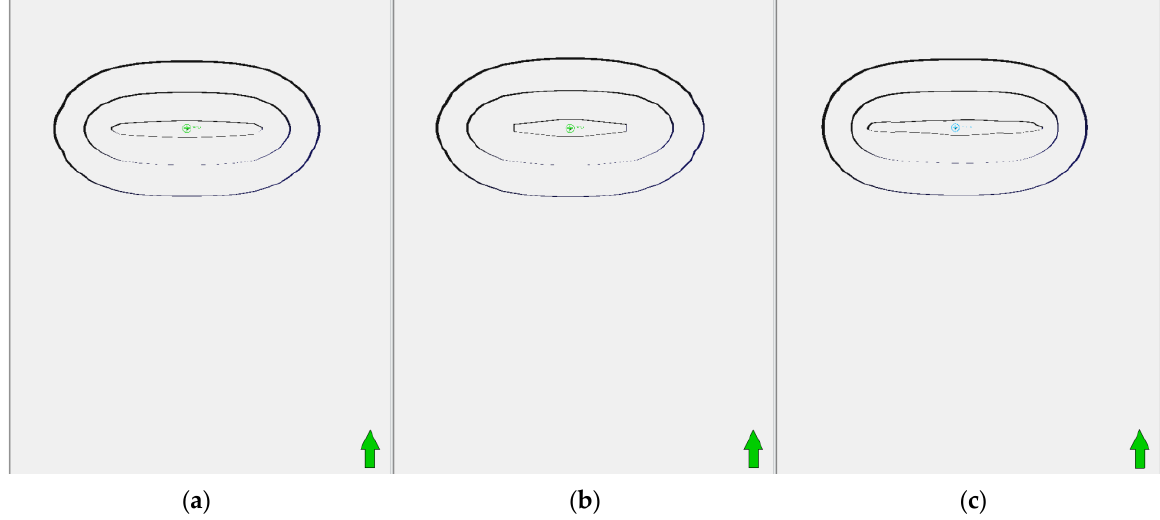
Figure 8. Pressure contour in early time for ( a ) Base Case, ( b ) Coarse Case, and ( c ) Reference.